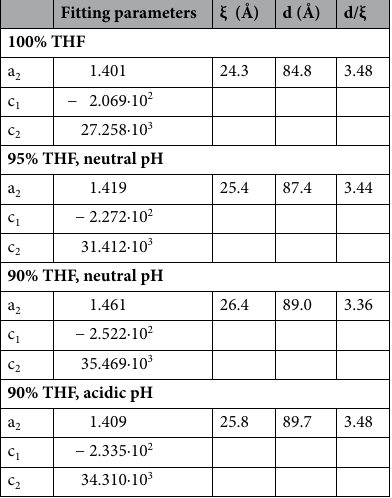
Fitting parameters ξ (Å) d (Å)